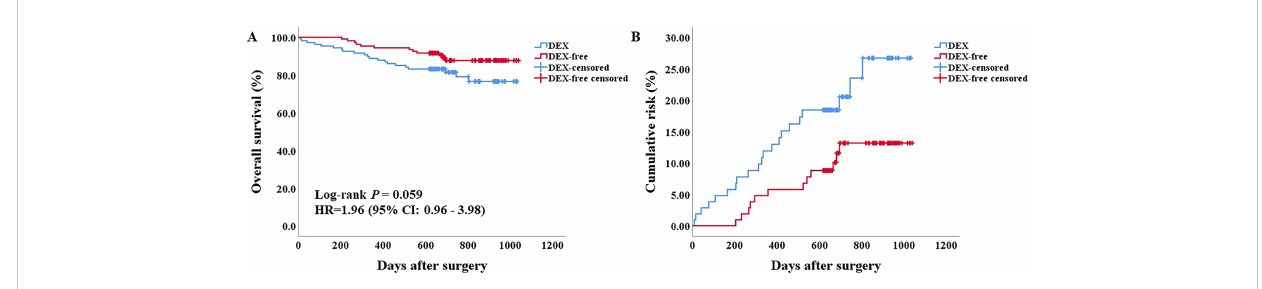
FIGURE 4 Survival analysis of patients after PSM. (A) the Kaplan – Meier survival curve of patients in the two groups. (B) the cumulative risk of patients in the two groups.